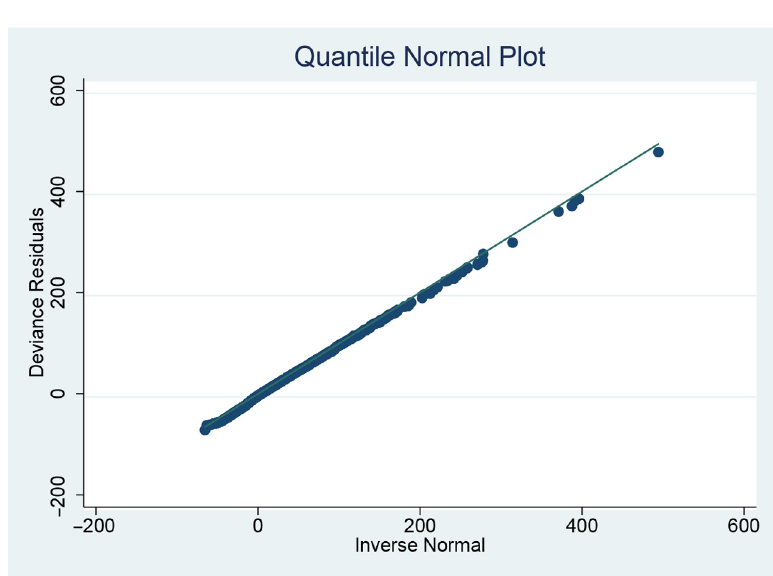
Figure 2. Quantiles of the residuals plotted against the quantiles of the normal distribution for